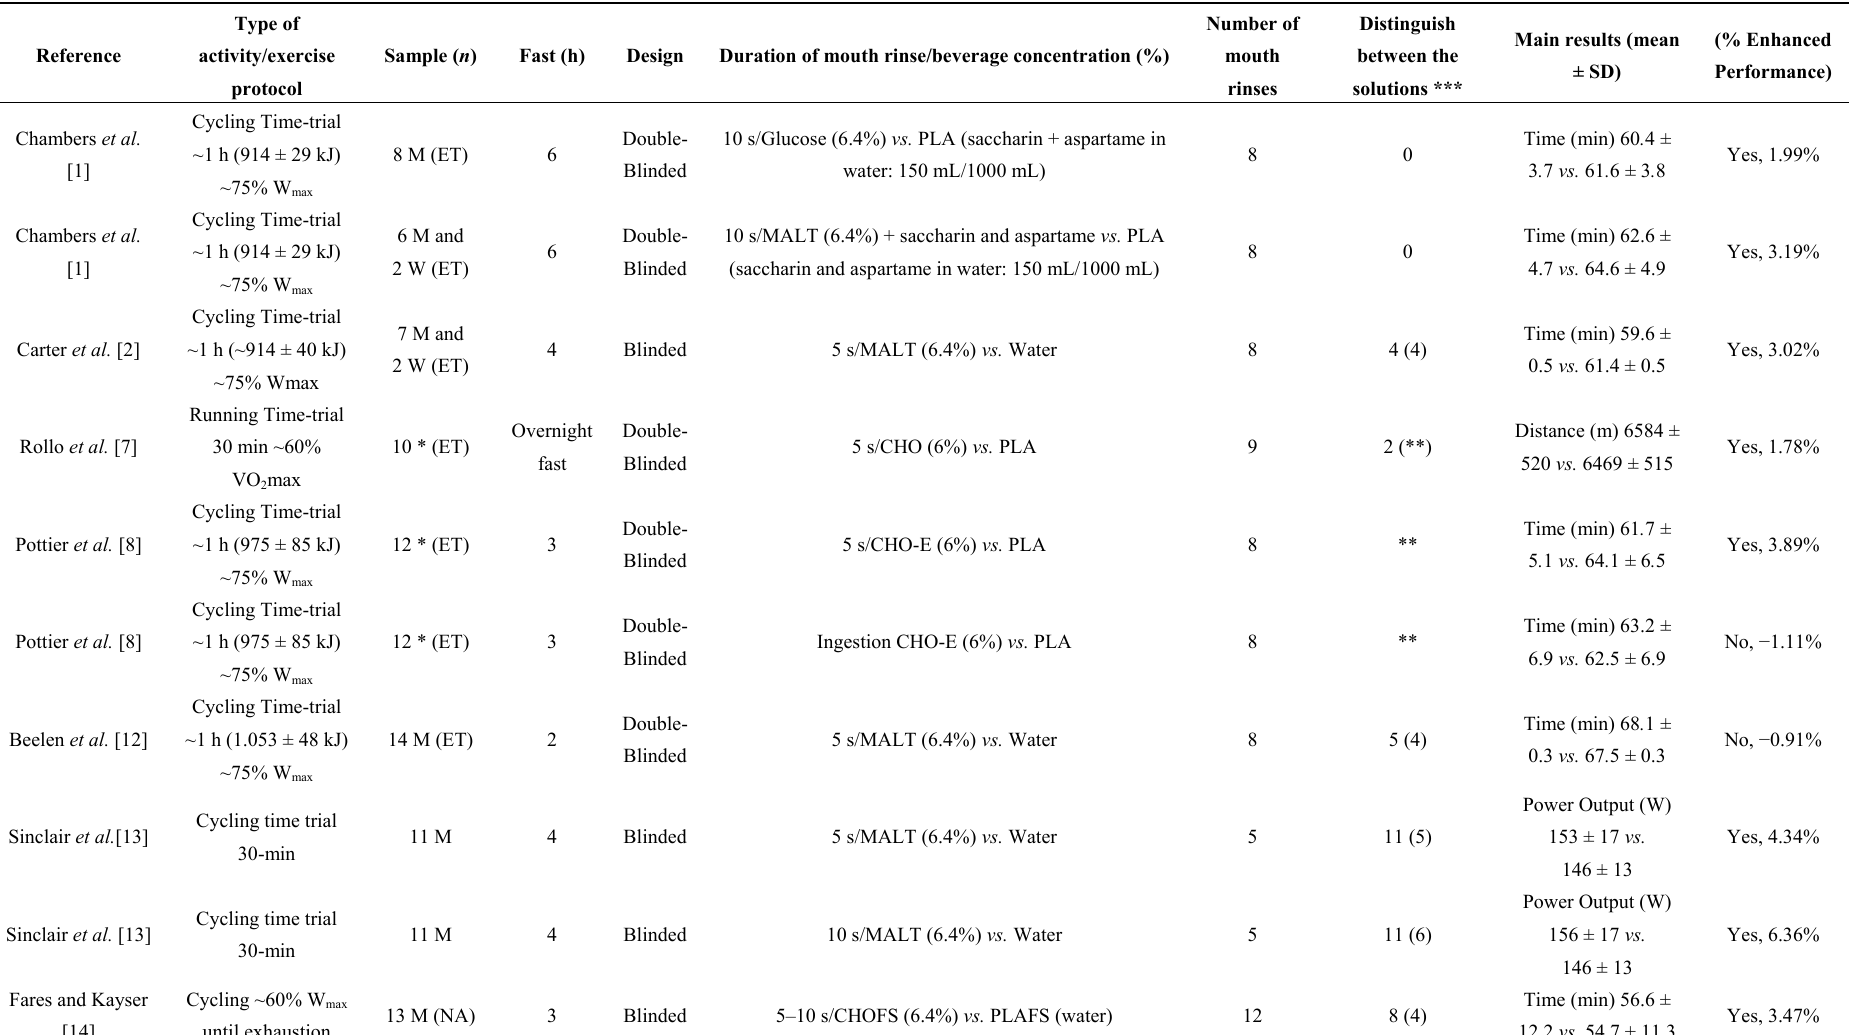
Table 1. Summary of the studies investigating the effect of carbohydrate mouth rinse on performance during